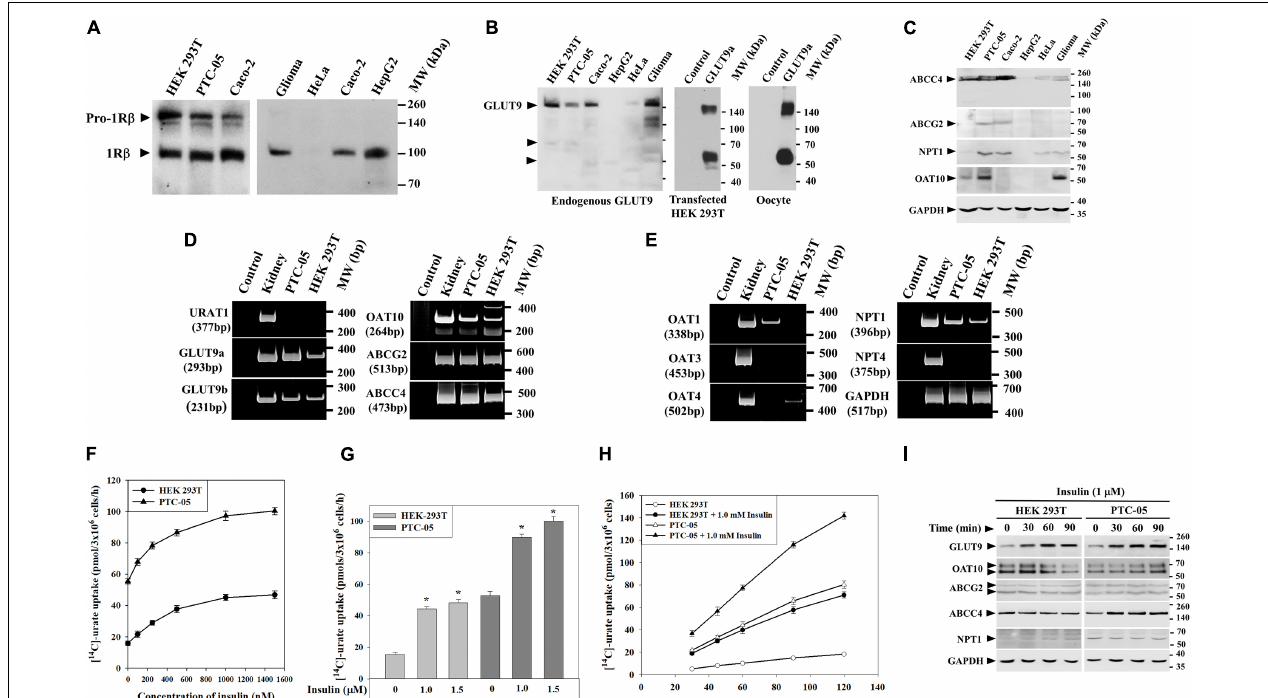
FIGURE 2 | Insulin stimulates [ 14 C ] -urate uptake in human renal proximal tubule epithelial cells (PTC-05) and HEK 293T cells. (A) Western blot analyses show endogenous INSR protein (IR β ; ∼ 96 kDa) expression in various human cell lines. (B) Western blot analyses show endogenous GLUT9 protein expression in various human cell lines in transiently transfected (GLUT9a) HEK 293T cells and Xenopus laevis oocytes. (C) Western blot analyses show endogenous ABCC4, ABCG2, OAT10 and NPT1 protein expression in various human cell lines. (D,E) RT-PCR detection of the mRNA expression of URAT1, GLUT9 isoforms (GLUT9a and GLUT9b), OAT10, ABCG2, ABCC4, OAT1, OAT3, OAT4, NPT1, NPT4 and GAPDH in human kidney, PTC-05 and HEK 293T cells. (F) Dose-response plots showing the total [ 14 C]-urate uptake activities of endogenous urate transporters, in equal number (3 × 10 6 ) of HEK 293T or PTC-05 cells, in response to